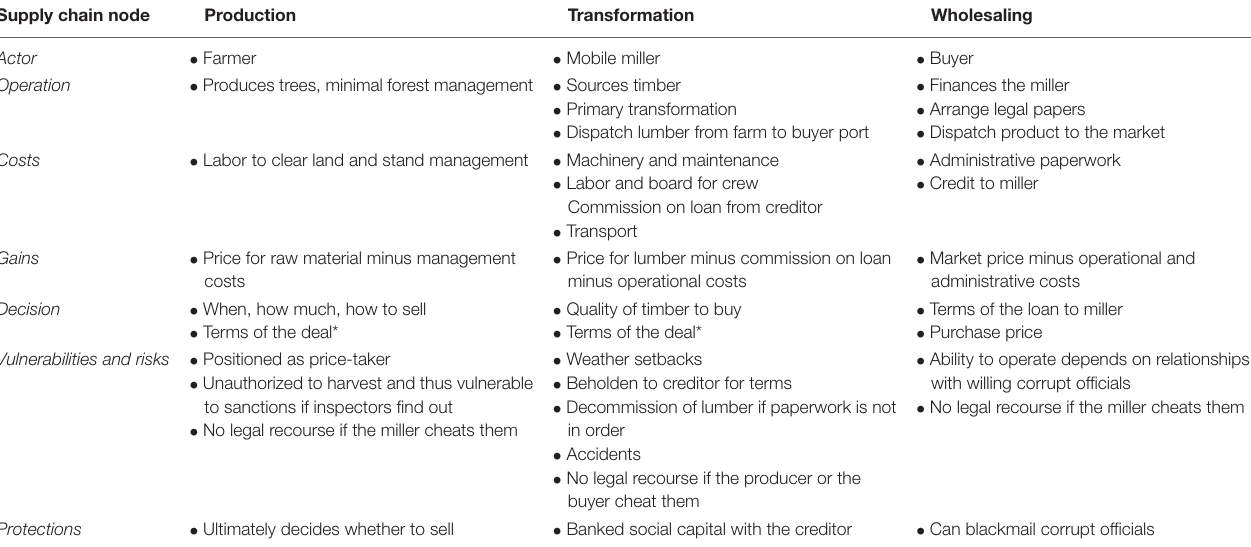
TABLE 1 | Fallow timber supply chain nodes, the actors, operations and other